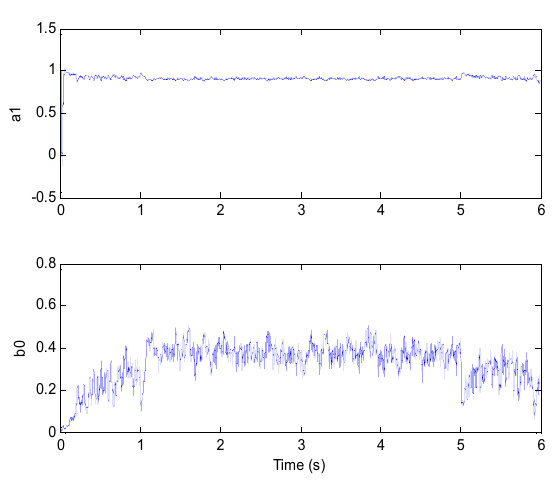
Figure 9. Model parameters (test 1).